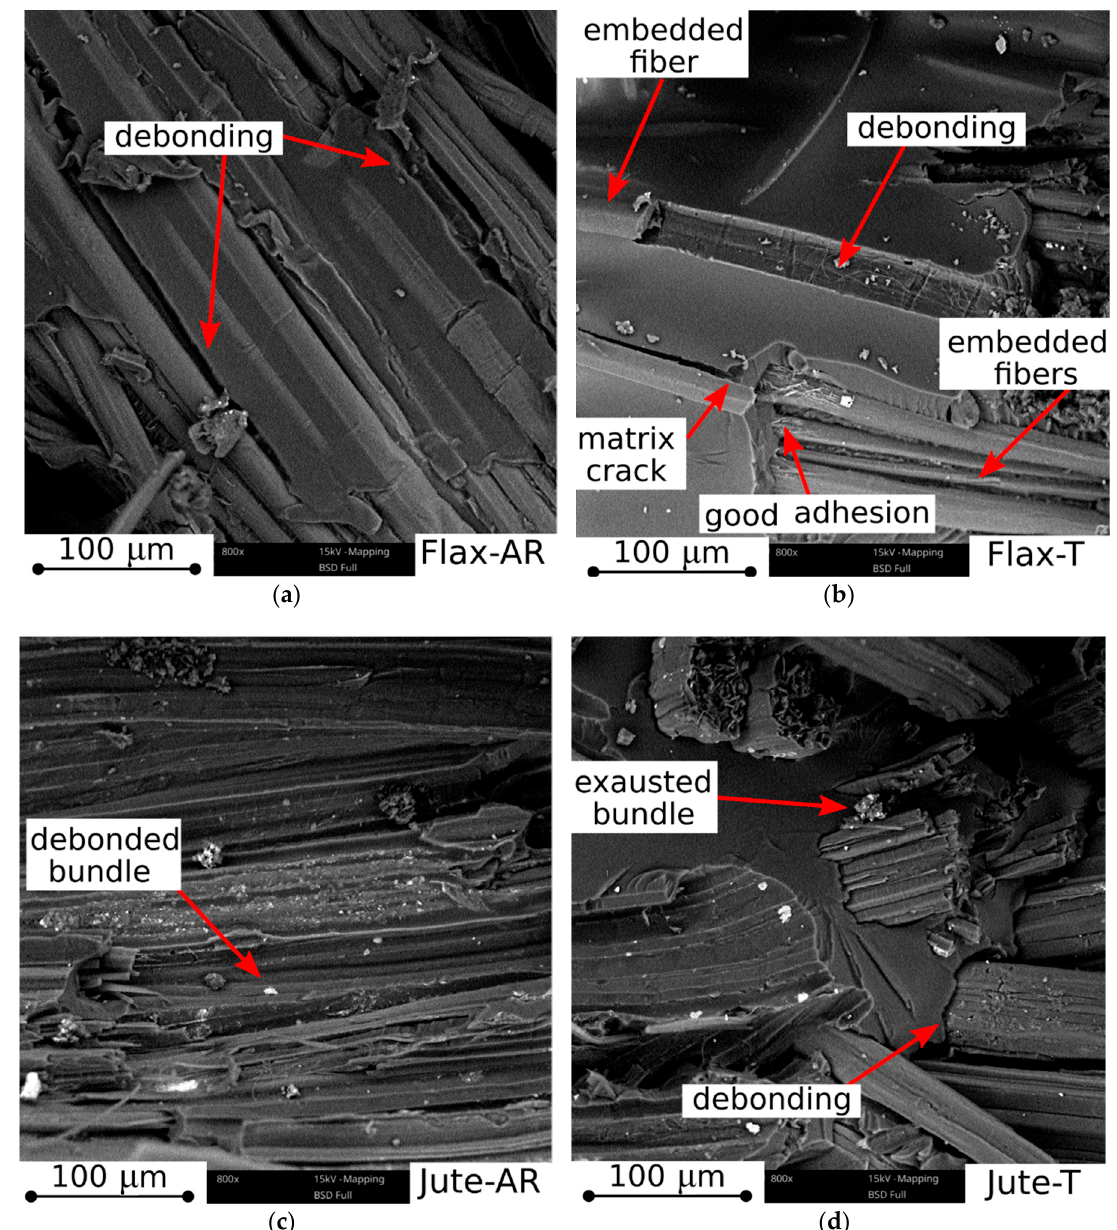
Figure 10. SEM micrographs of impact fracture surfaces of untreated and treated jute and flax reinforced composites: ( a ) Flax-AR, ( b ) Flax-T, ( c ) Jute-AR, and ( d ) Jute-T samples